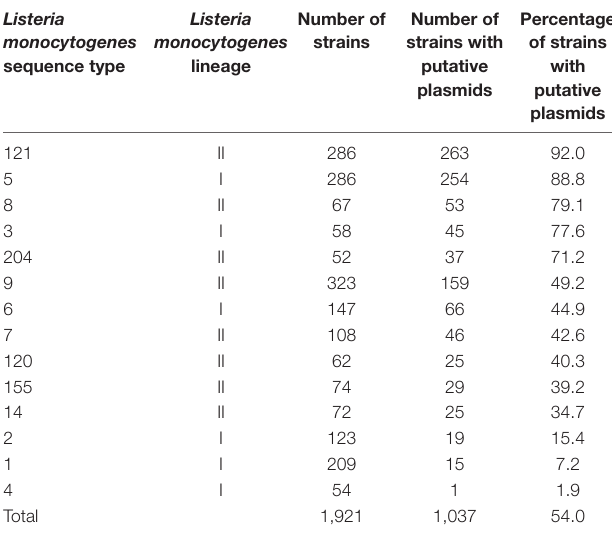
TABLE 2 | Number and percentage of potential plasmids identified in Listeria monocytogenes strains from different STs. Listeria monocytogenes